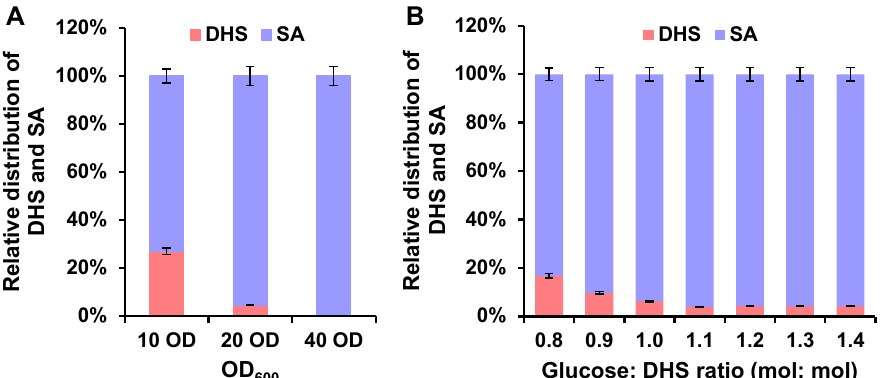
Figure 6. Effects of OD 600 ( A ) and glucose ( B ) on conversion rate of DHS for whole-cell biocatalysis on a large scale. ( A ) The biocatalyst load for efficient whole-cell biocatalysis was tested between 10 and 40 OD 600 with 1.5 equivalents of glucose; ( B ) the glucose load was examined with various equivalents of glucose (0.8–1.4) using 20 OD 600 of RSF-serA whole-cell biocatalyst. The reactions were carried out on a 1 L scale at 34 °C, pH 7.0 with 80 g/L DHS, and the concentrations of DHS and SA were determined at 1.5 h. Data are presented as the mean ± standard deviation of two independent experiments.